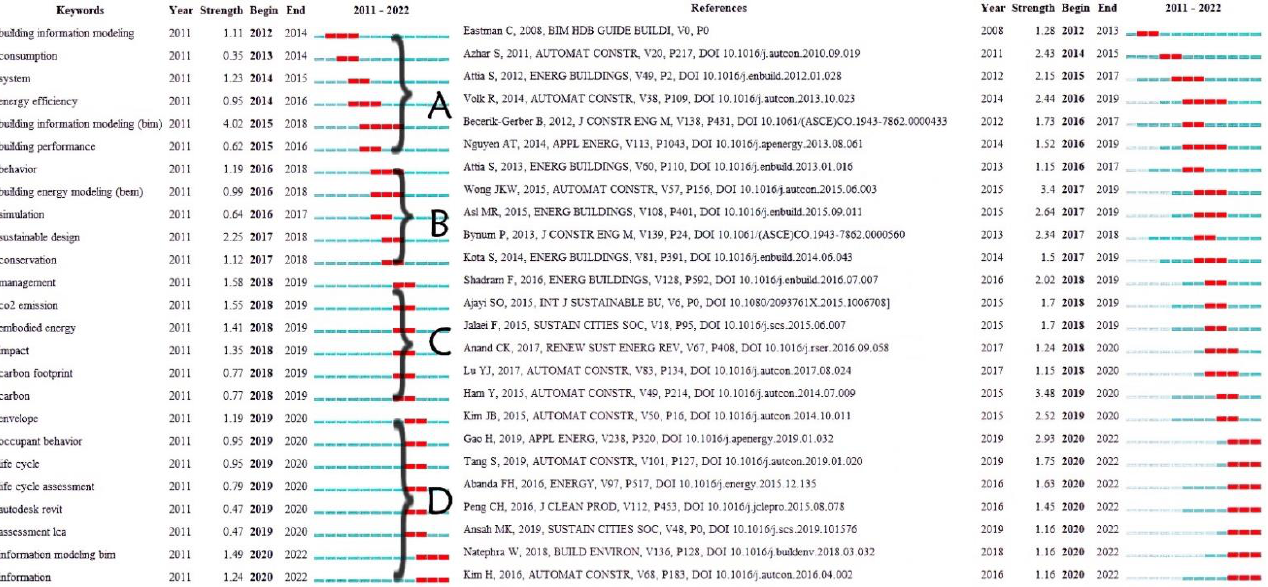
Figure 10. Burst terms and burst articles of BIM technology in building energy consumption re- search.